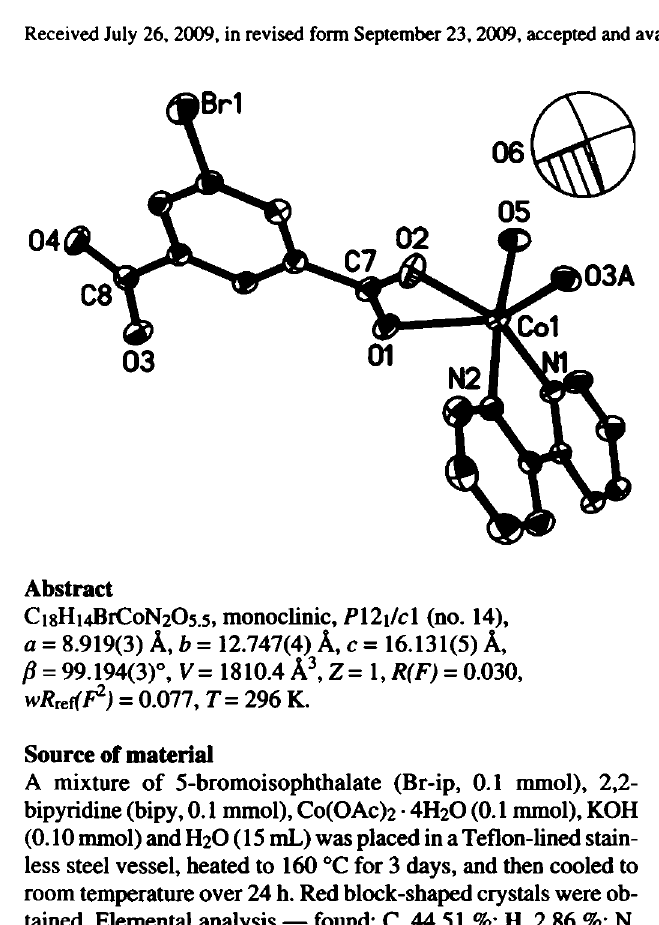
Table 2. Atomic coordinates and displacement parameters (in Â 2